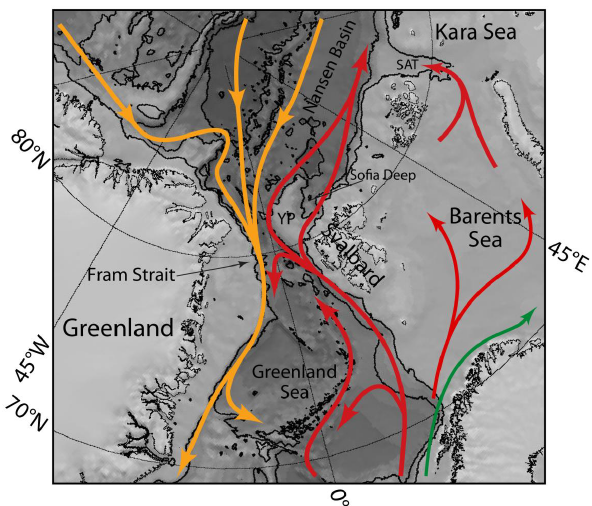
Fig. 1 Fig. 1. Fram Strait bathymetry and AW circulation (red AW and orange AAW). Green arrow is Norwegian Coastal Current. YP = Yermak Plateau, SAT = Saint AnnaTrough.